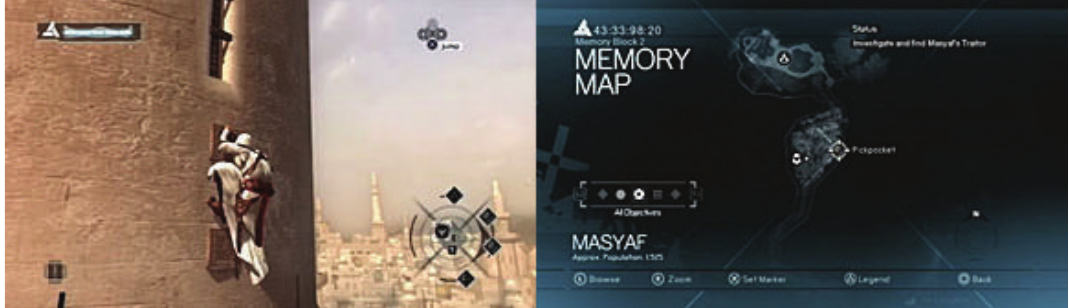
Figure 8: The play screen and map menu of Assassin’s Creed (source: Ubisoft, 2007; image from IGN.com, used with permission).